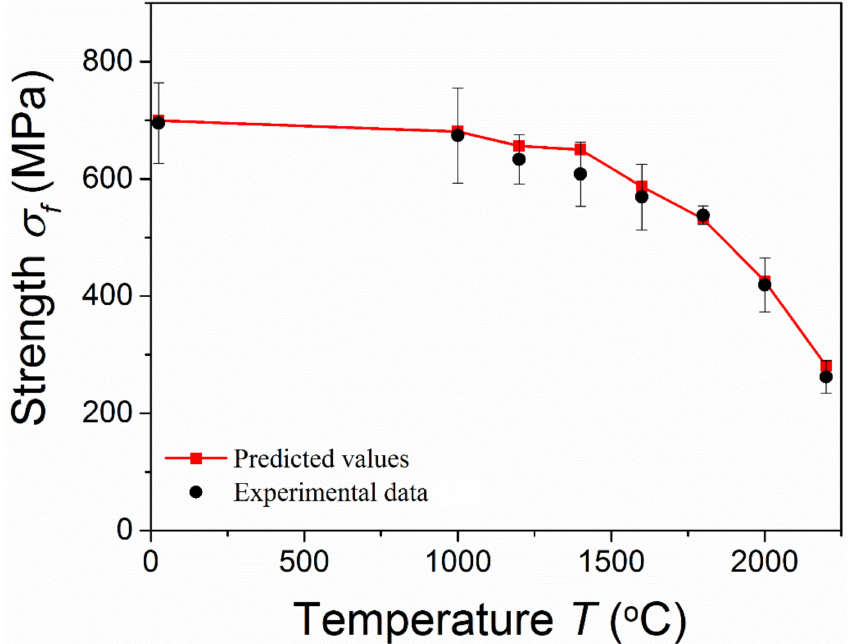
Figure 6. Temperature-dependent fracture strength of ZrB 2 –30%SiC–2vol%B 4 C